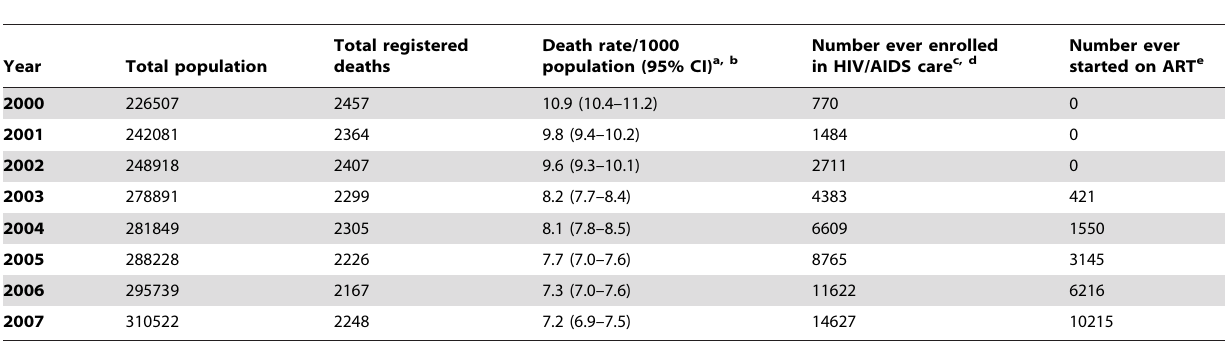
Table 1. Registered deaths at five traditional authorities and relationship to enrolment in HIV/AIDS care and antiretroviral treatment (2000–2007), Thyolo district,